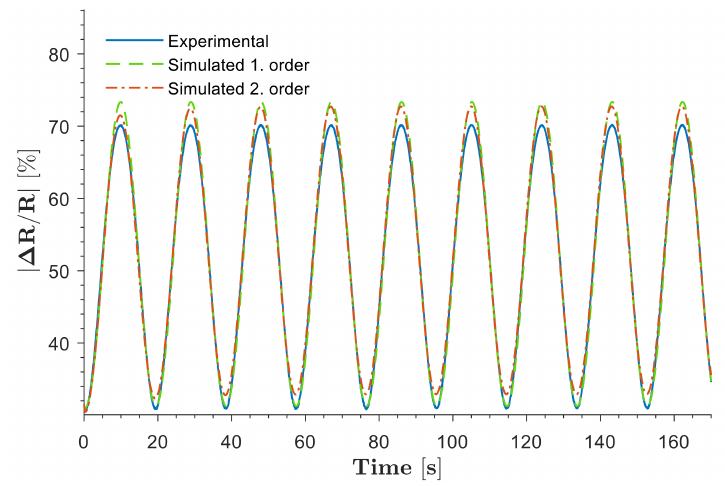
Figure 9. Comparison between the actual experimental response of SoHapS and the dynamic models.